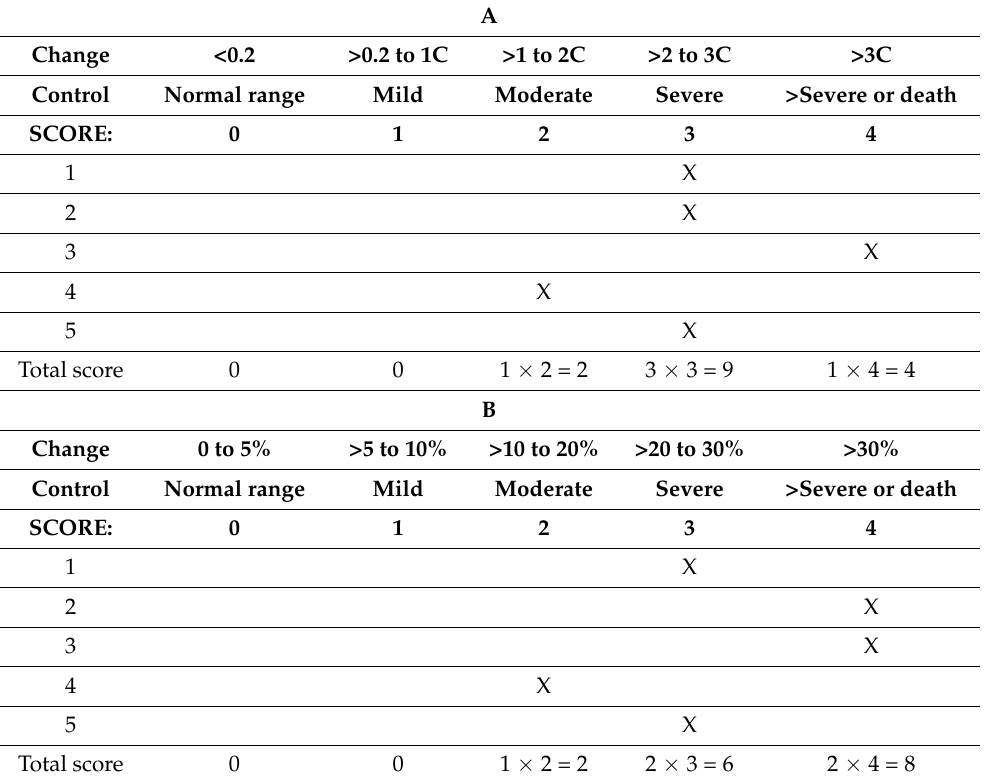
Table 2. (A) The proposed scoring matrix for body temperature (high dose). (B) The proposed scoring matrix for body weight (high